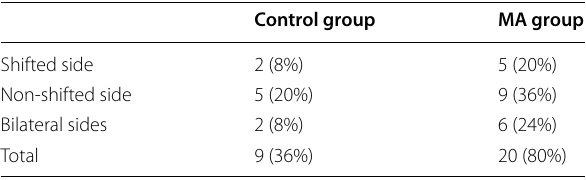
Table 4 Temporomandibular joint disorder symptoms